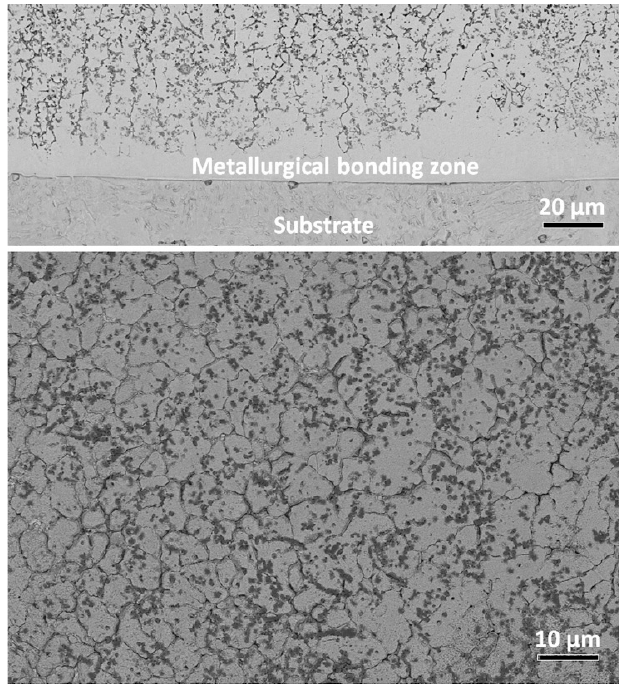
Figure 12. SEM micrographs for the cross section of the Cr 20 Cu 20 Fe 20 Ni 20 Al 20 HEA composite coating reinforced with particles of titanium carbonitride on the Q235 steel substrate. ( upper part ) The image of macro-morphology; ( lower part ) BSE image of the upper-middle area. Micrographs are reprinted with permission from ref. [14]. Copyright 2021 Elsevier.